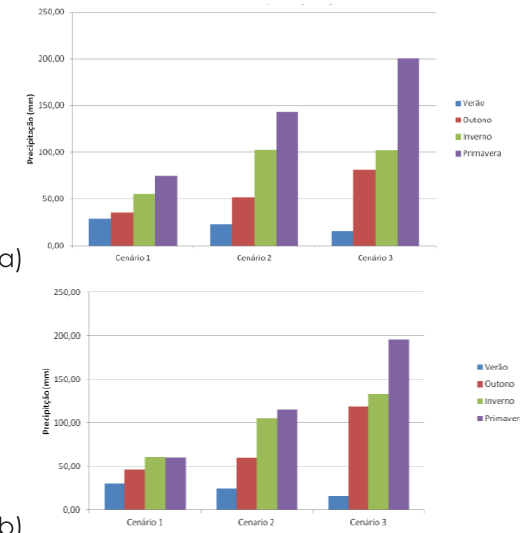
Figure 4. Seasonal Precipitation Anomalies: a) station 01 and b) station 02 Based on the average precipitation projections of the hydrographic basin where the Machadinho HPP is located, it was observed that the highest values of precipitation are found in the western half of the basin, fluctuating around 200 mm for scenario 1 (Figure 5a)